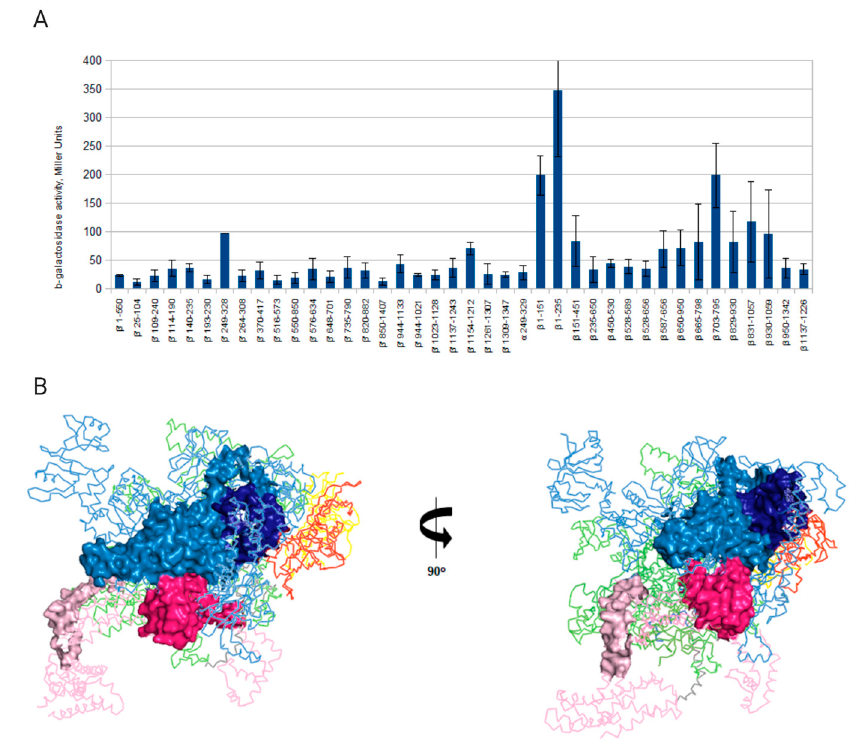
Figure 4. GpT5.026 binding sites on an E. coli RNAP holoenzyme. ( A ) Identification of gpT5.026 binding sites on host RNAP subunits with a bacterial two-hybrid assay. Two-hybrid proteins were co-expressed in E. coli cells bearing a lacZ reporter gene under the control of the lac -promoter and O L 2 operator. One of the hybrid proteins consists of the part of the RNAP α subunit and gpT5.026, while another one is a fusion between CI and fragments of β , β ’, or α subunits of E. coli RNAP (amino acid positions of these fragments are indicated on the abscissa under corresponding bar). Cells containing hybrid proteins were disrupted, and β -galactosidase activity was measured in crude extracts (described in Materials and Methods). The experiment was conducted in four replicates. Means and standard deviations from the mean are shown. ( B ) Crystal structure of the E. coli RNAP holoenzyme at 3.6A° resolution (4LJZ, [37]). The β ’, two α , and ω subunits are made transparent for better perception, and are colored green, red/yellow, and grey, respectively. The σ 70 subunit is shown in pink (regions 1.2 and 3.1 are marked pale pink and dark pink, respectively, and are shown by surface representation) and the β subunit is shown in blue (amino acids 1 to 151 and 703 to 795 are marked pale and dark blue, respectively, and shown by surface representation).